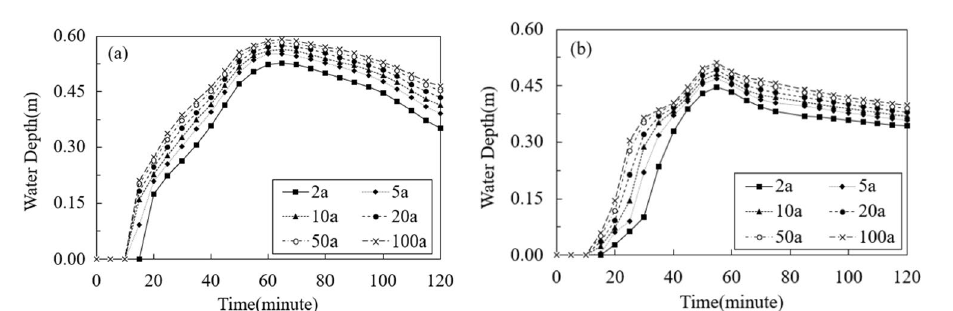
Figure 8. Changes of water depths at ( a ) the northwest spot and ( b ) the southern spot. This graph was generated with OriginPro 2021 (Learning Edition)(https:// www. origi nlab.